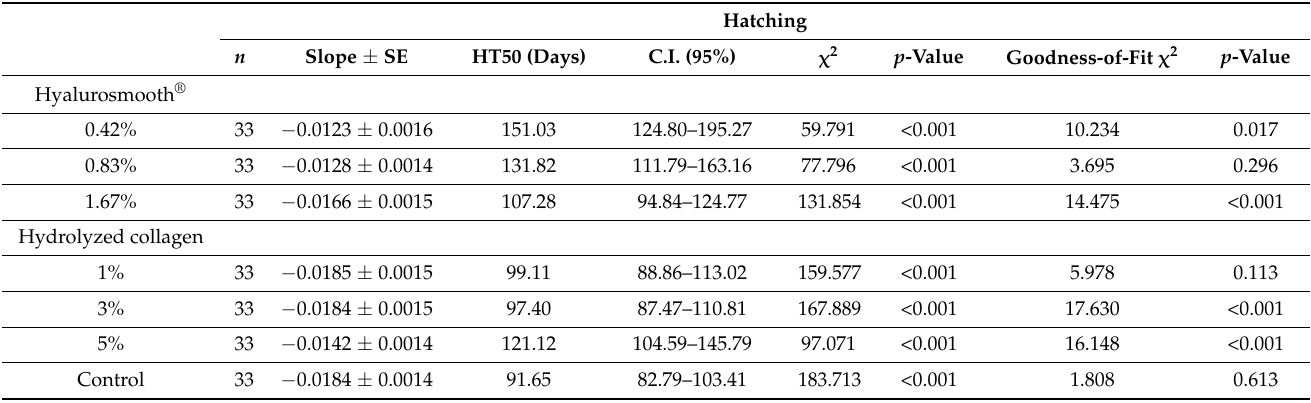
Table 2. Probit analysis for different doses of Hyalurosmooth ® and hydrolyzed collagen as preserva- tives of Ae . aegypti eggs, in southern